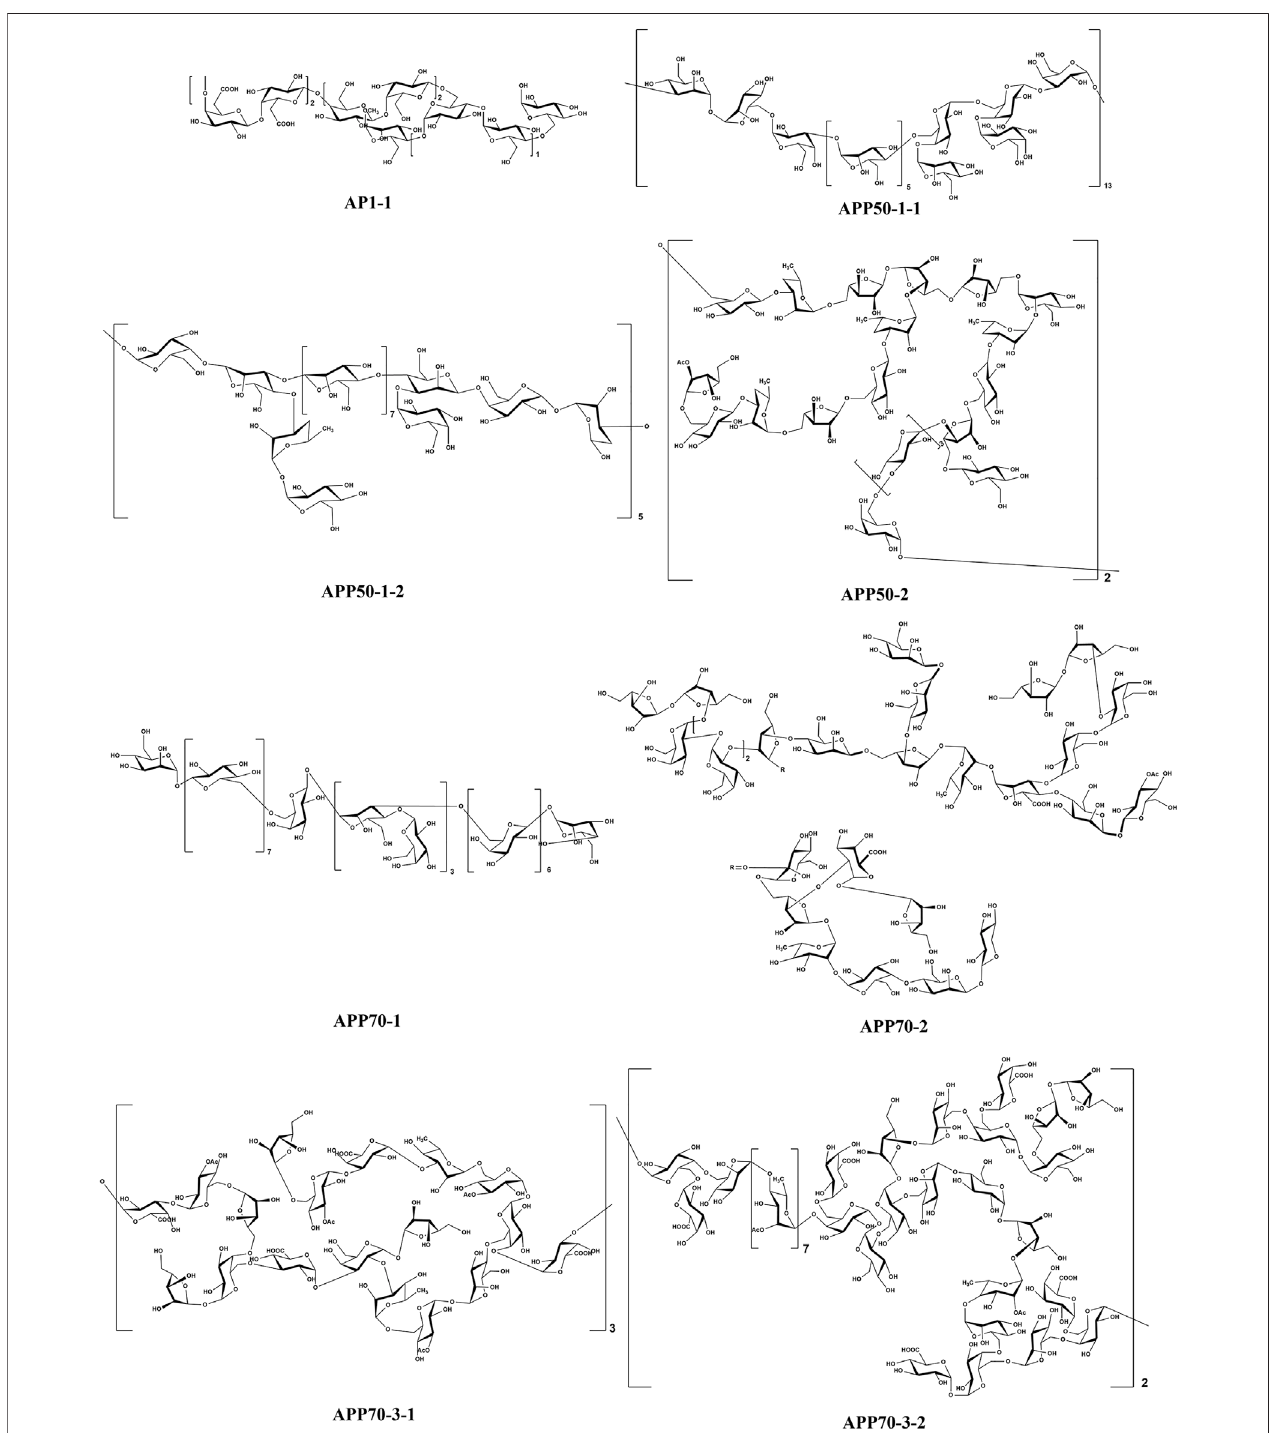
FIGURE 9 | Chemical structures of